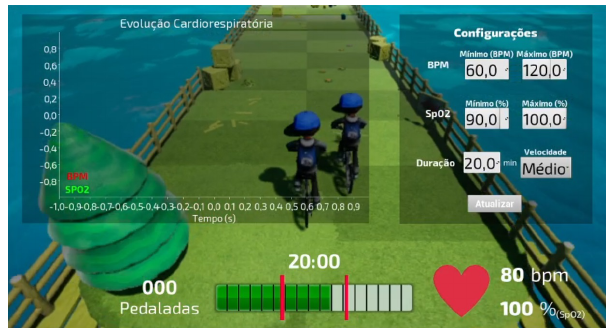
Figure 4. Physiotherapist’s screen in “Player” mode (in